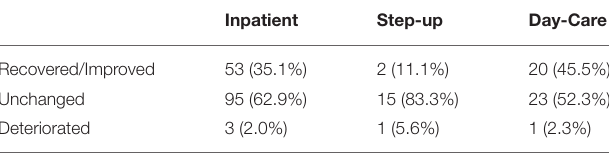
TABLE 3 | Clinical significance outcomes for the EDE-Q global